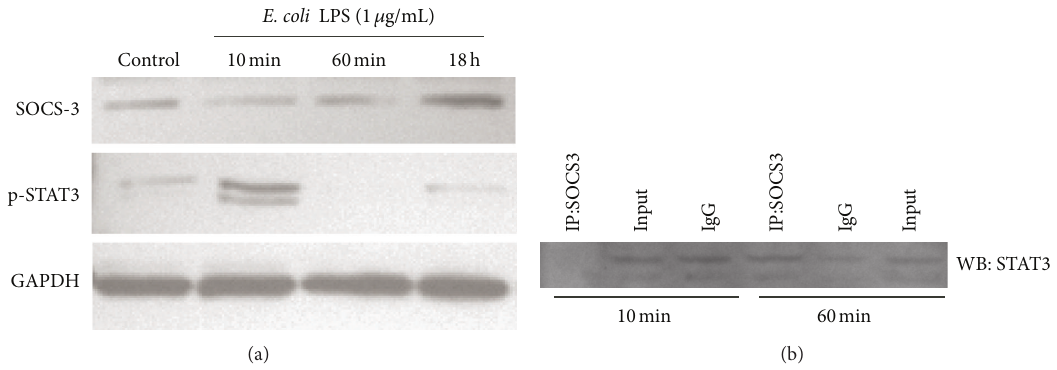
Figure 5: LPS stimulation transiently activates STAT3 in raw 264.7 macrophages. Expression of SOCS3 was increased only after 18h of LPS stimulation (a). Coimmunoprecipitation indicates a dynamic direct physical interaction between SOCS3 and STAT3 in murine macrophages. Raw 264.7 cells were stimulated with LPS (or the same volume of PBS vehicle) for 10 and 60min. SOCS3 was immunoprecipitated from 500 ug of cell lysates, and after electrophoretic separation (SDS-PAGE), STAT3 was detected by western blotting. “Input” indicates the same quantity of cell lysate loaded onto “empty” affinity columns (no primary antibody immobilized), and “IgG” represents columns in which the same quantity of irrelevant IgG from rabbit was immobilized in the columns. Image is representative of three independent